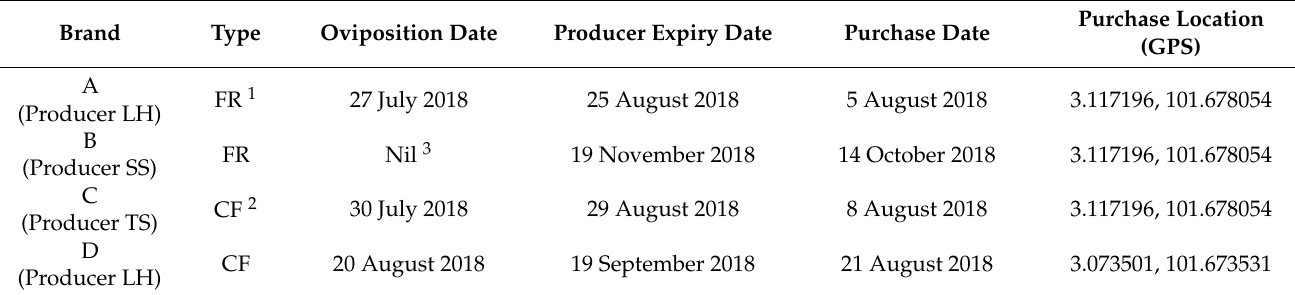
Table 1. Samples